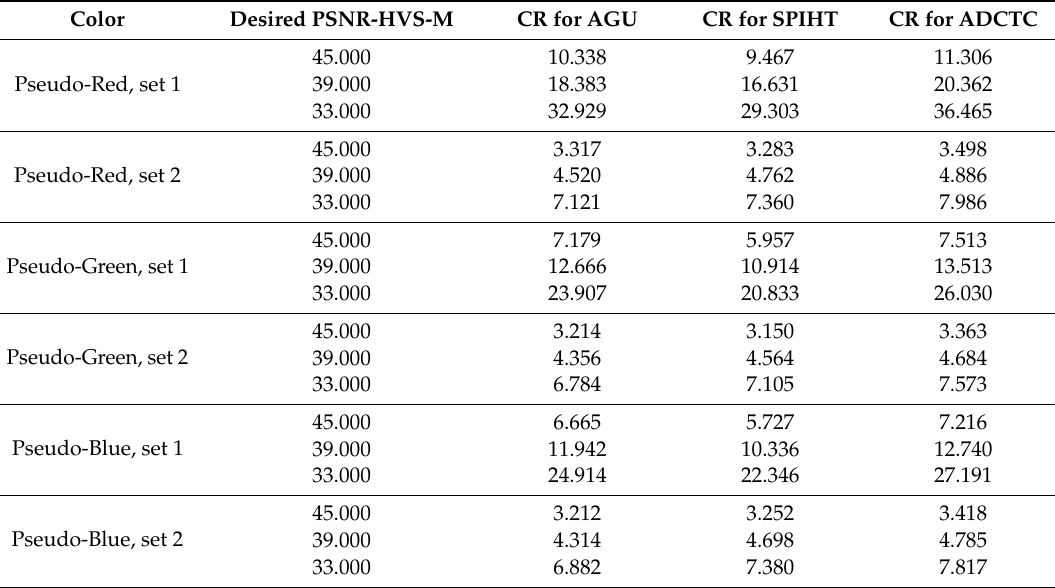
Table 22. CR comparison for real-life data for three coders, both sets.